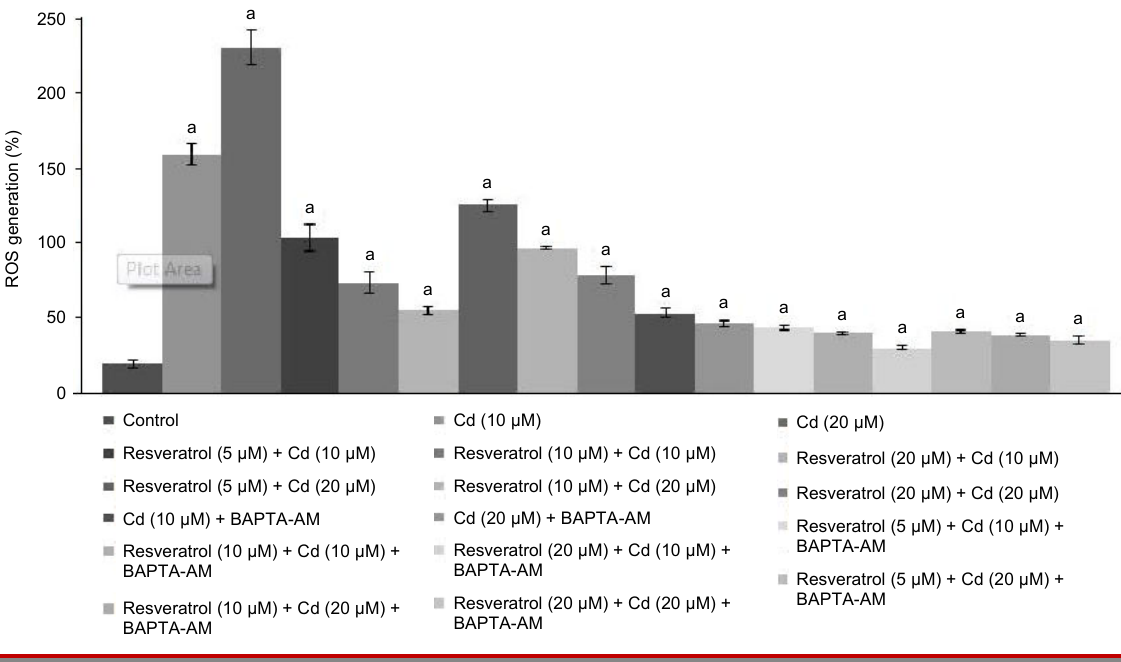
Figure 3: Resveratrol inhibits Cd-induced ROS generation Values are represented as mean ± SD; n=6; a represents statistical significance at p<0.05 compared against control as determined by one-way the order: BAPTA-AM and resveratrol (20 µM)> decrease in ROS levels by resveratrol could be BAPTA-AM and resveratrol (10 µM)>BAPTA-AM and attributed to its antioxidant potency. BAPTA-AM also resveratrol (5 µM). The results suggest that effective caused reduction in ROS level suggesting BAPTA-AM